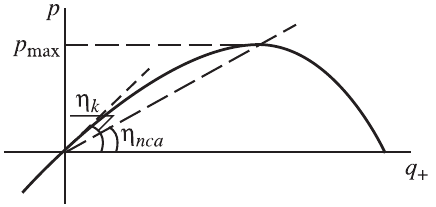
Figure 3. The pattern of the dependence of converter power on the cost of